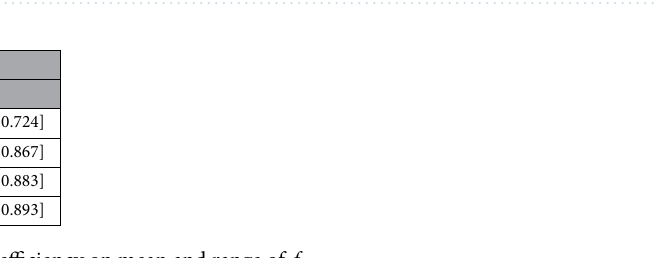
Table 3. Impact of contact tracing efficiency on mean and range of f S